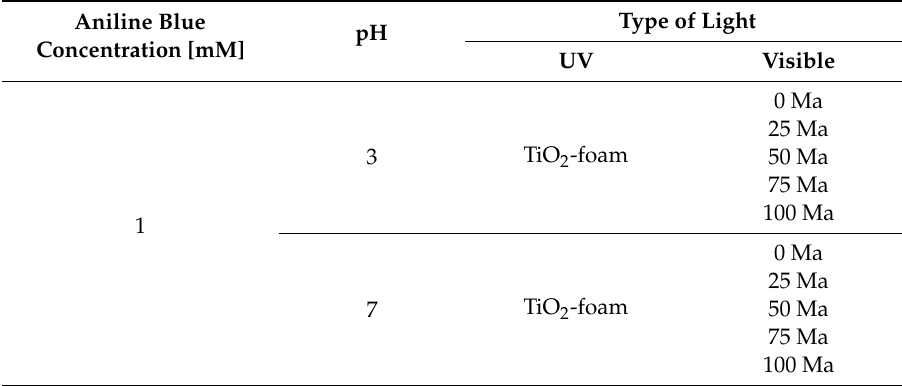
Table 5. Parameters of the photocatalytic degradation process of aniline